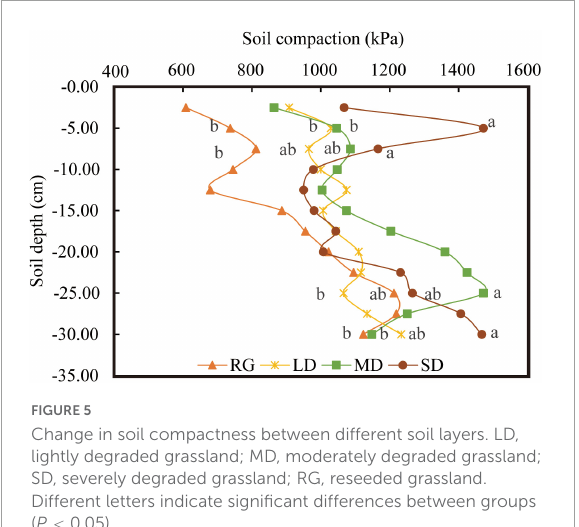
FIGURE5 Change in soil compactness between different soil layers. LD, lightly degraded grassland; MD, moderately degraded grassland; SD, severely degraded grassland; RG, reseeded grassland. Different letters indicate significant differences between groups ( P < 0.05).